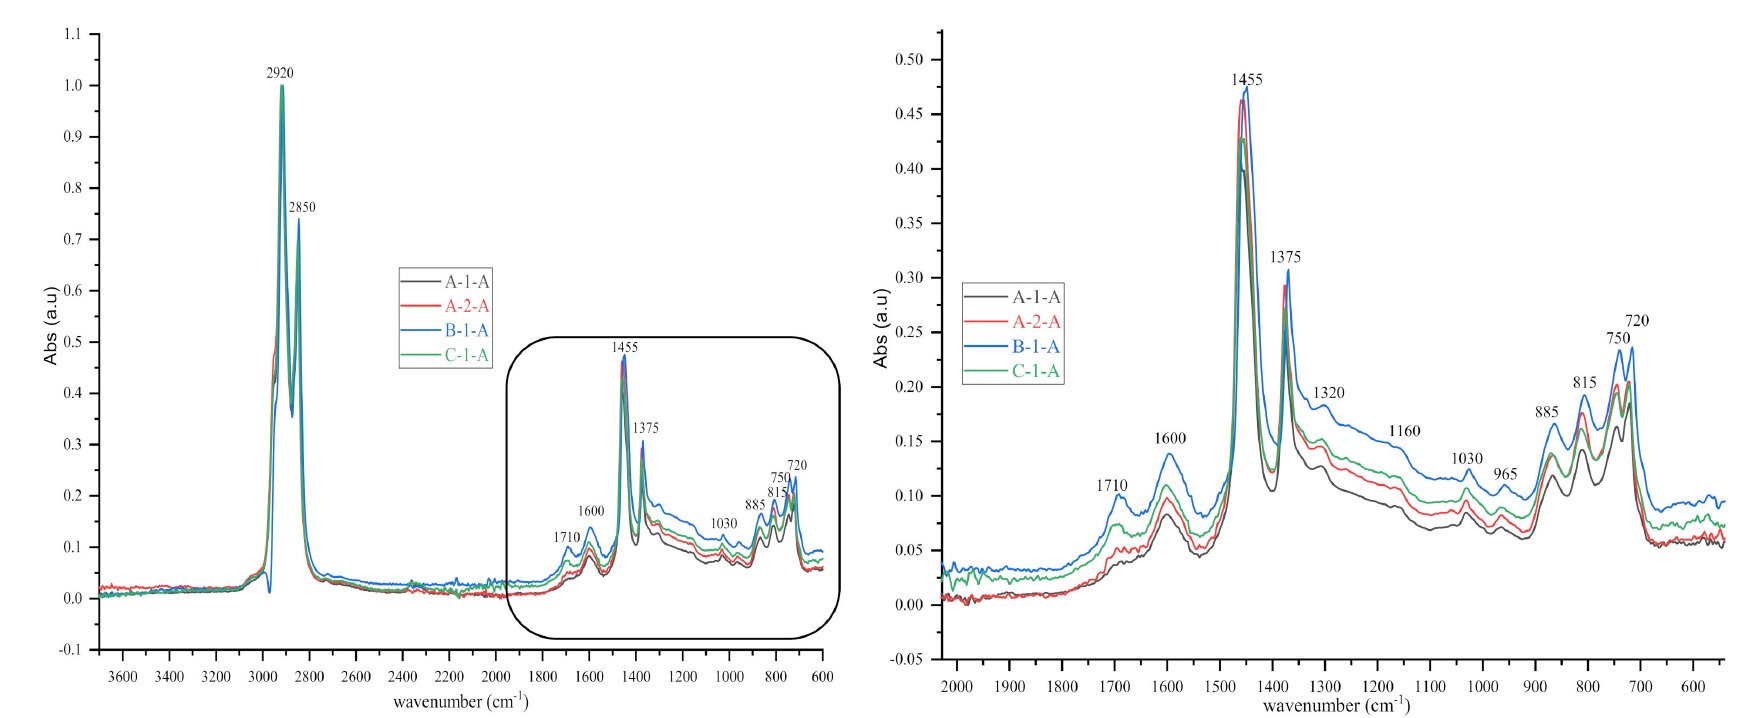
Figure 8. IR spectra (3700–600 cm -1 and 2000–600 cm -1 ) of some bituminous binders before short-term ageing